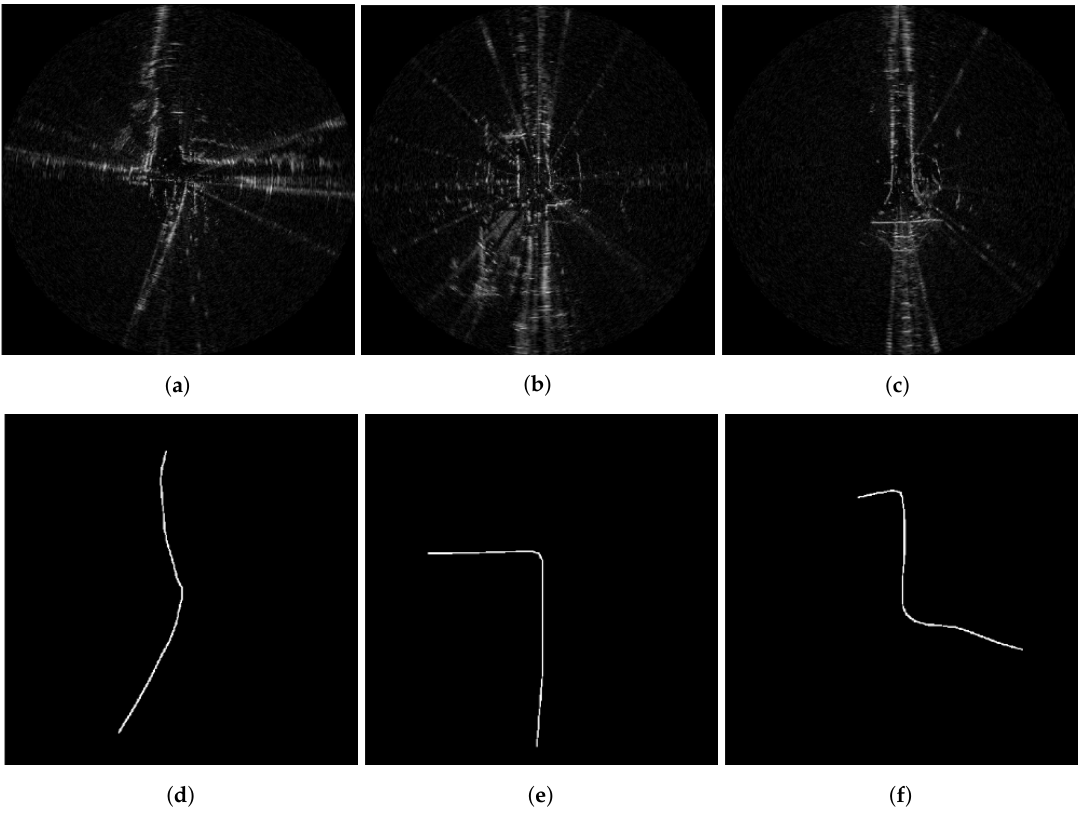
Figure 11. Radar scans and corresponding route labels at junctions, prepared as per Section 4.1. In ( a , d ), the vehicle veers left while travelling south-to-north. In ( b , e ), the vehicle takes a left turn while travelling north. In ( c , f ), the vehicle takes a right turn shortly after taking a left turn. All of these driving behaviours (and others) are possible in various scenes typically sensed by the radar at long range, and we expect that the Neural Network (NN) model designed in Section 4.2 below will generalise beyond simply learning the demonstrations shown to it during training. We indicate this experimentally in Section